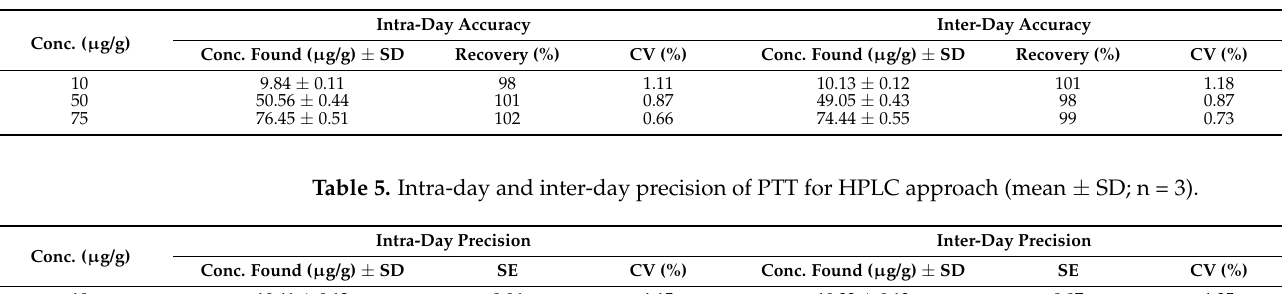
Table 4. Intra-day and inter-day accuracy results of PTT for HPLC approach (mean ± SD; n = 3).